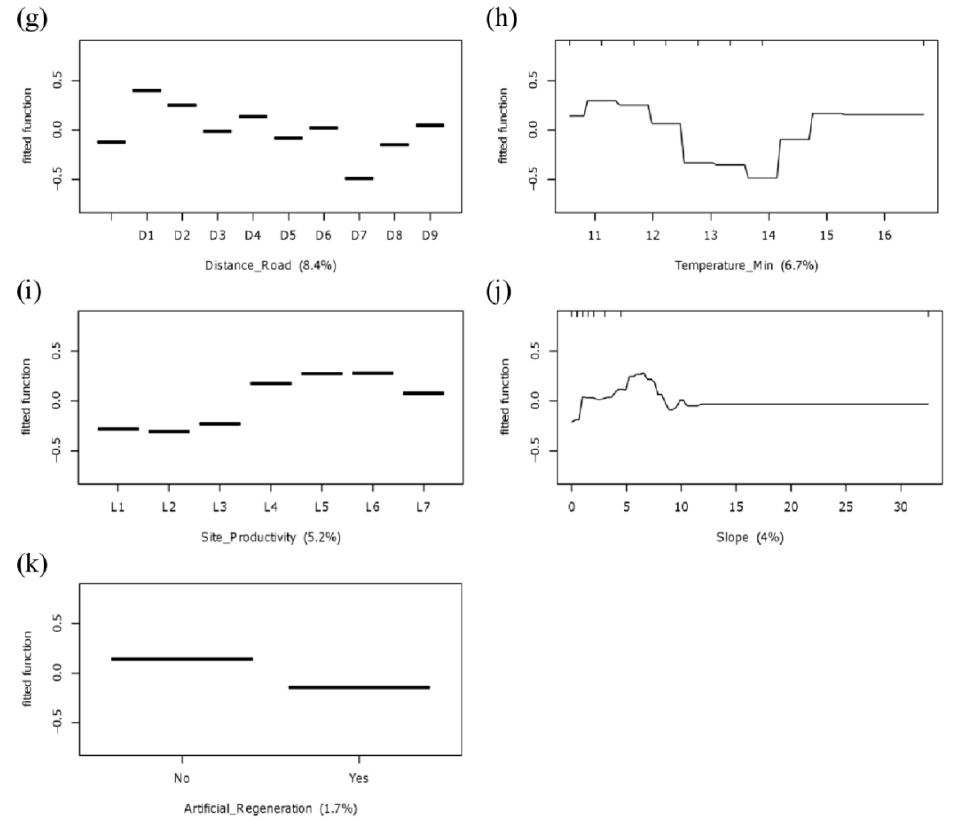
Figure 2. Partial dependence plots for the explanatory variables included in the optimal boosted regression tree models for Japanese honeysuckle based on analyses of the 11 most influential variables. Hash marks at the top of each plot indicate distribution of sample plots along the range of the indicated variable. X axis labels include the relative contributions (%) of each influential variable included in the final model (see Table 1 for the description of variables). Y axes are based on the logit scale used for the indicated variable.